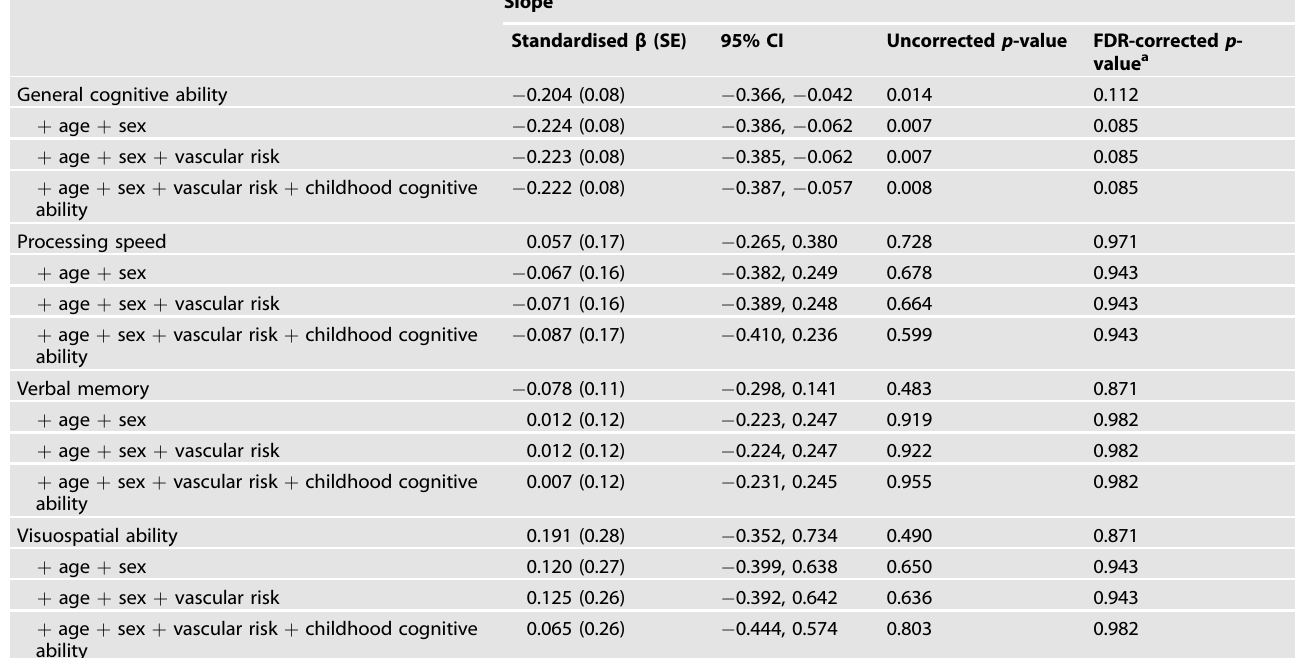
Table 4. Results of bifactor models of associations between total SVD burden and slope of latent cognitive variables between age 73 and